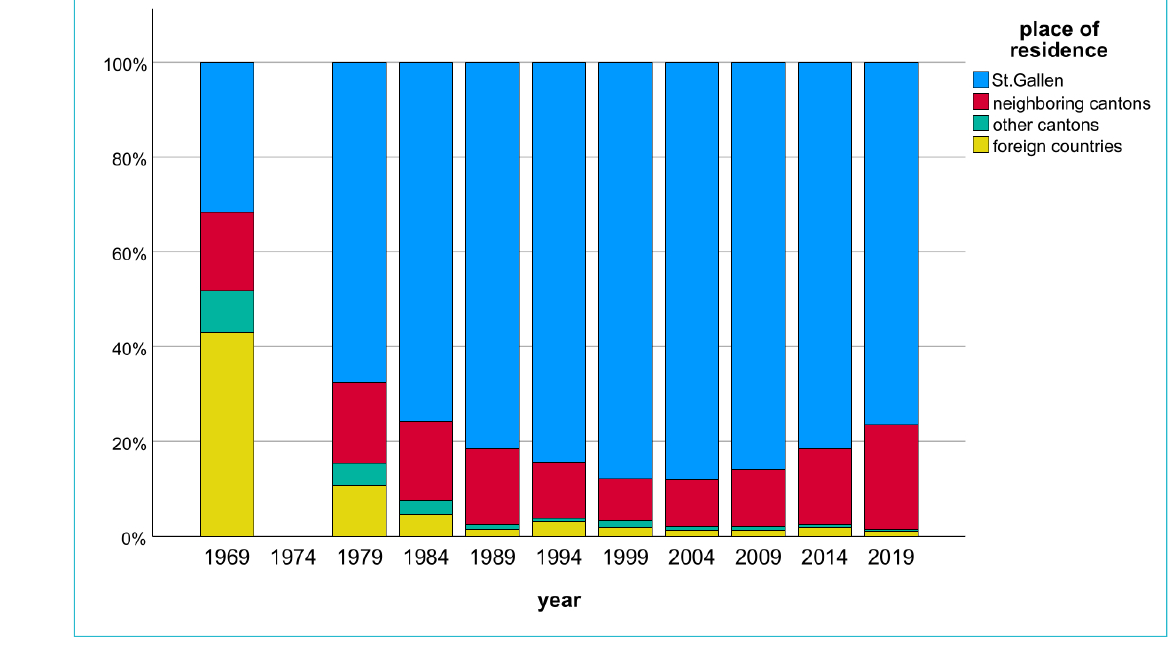
Figure 5: Place of residence of patients with artificial hip joint replacements (total, revision, or hemiprostheses) in the Kantonsspital St.Gallen from 1969 to 2019 at 5-year